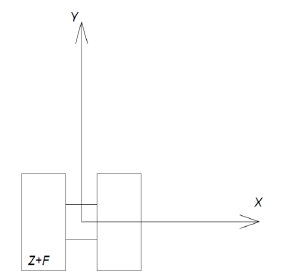
Figure 4. Local scanners coordinate system (seen from top)